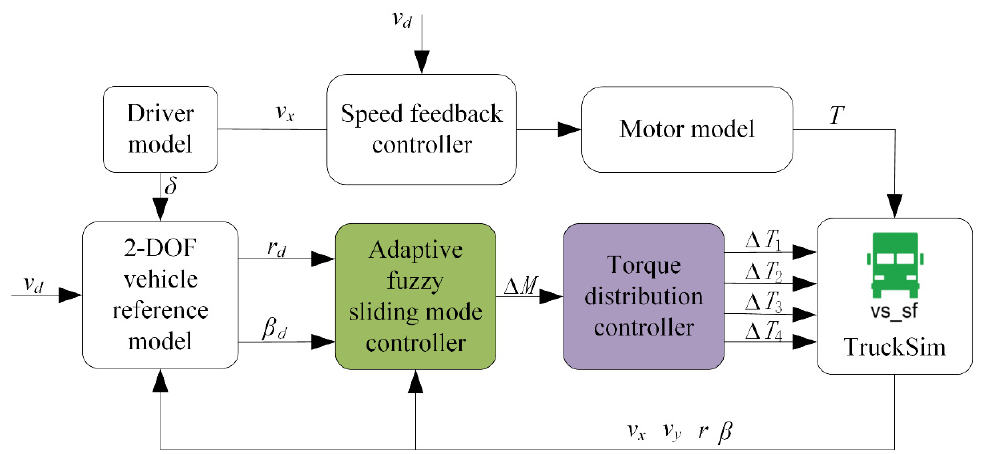
Figure 3. The control structure of the direct yaw moment.